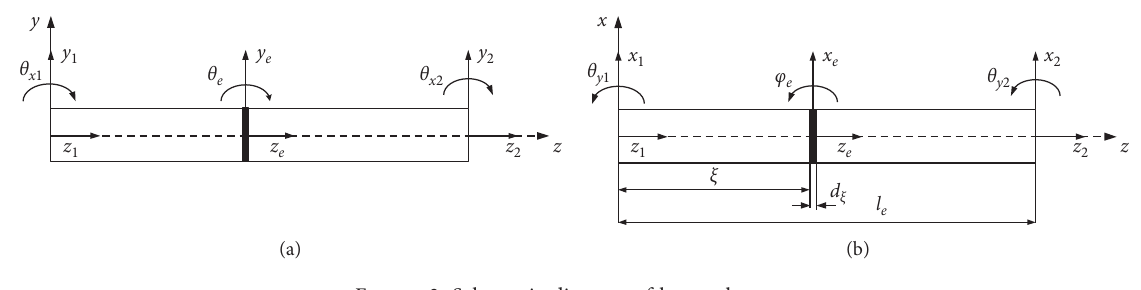
Figure 2: Schematic diagram of beam